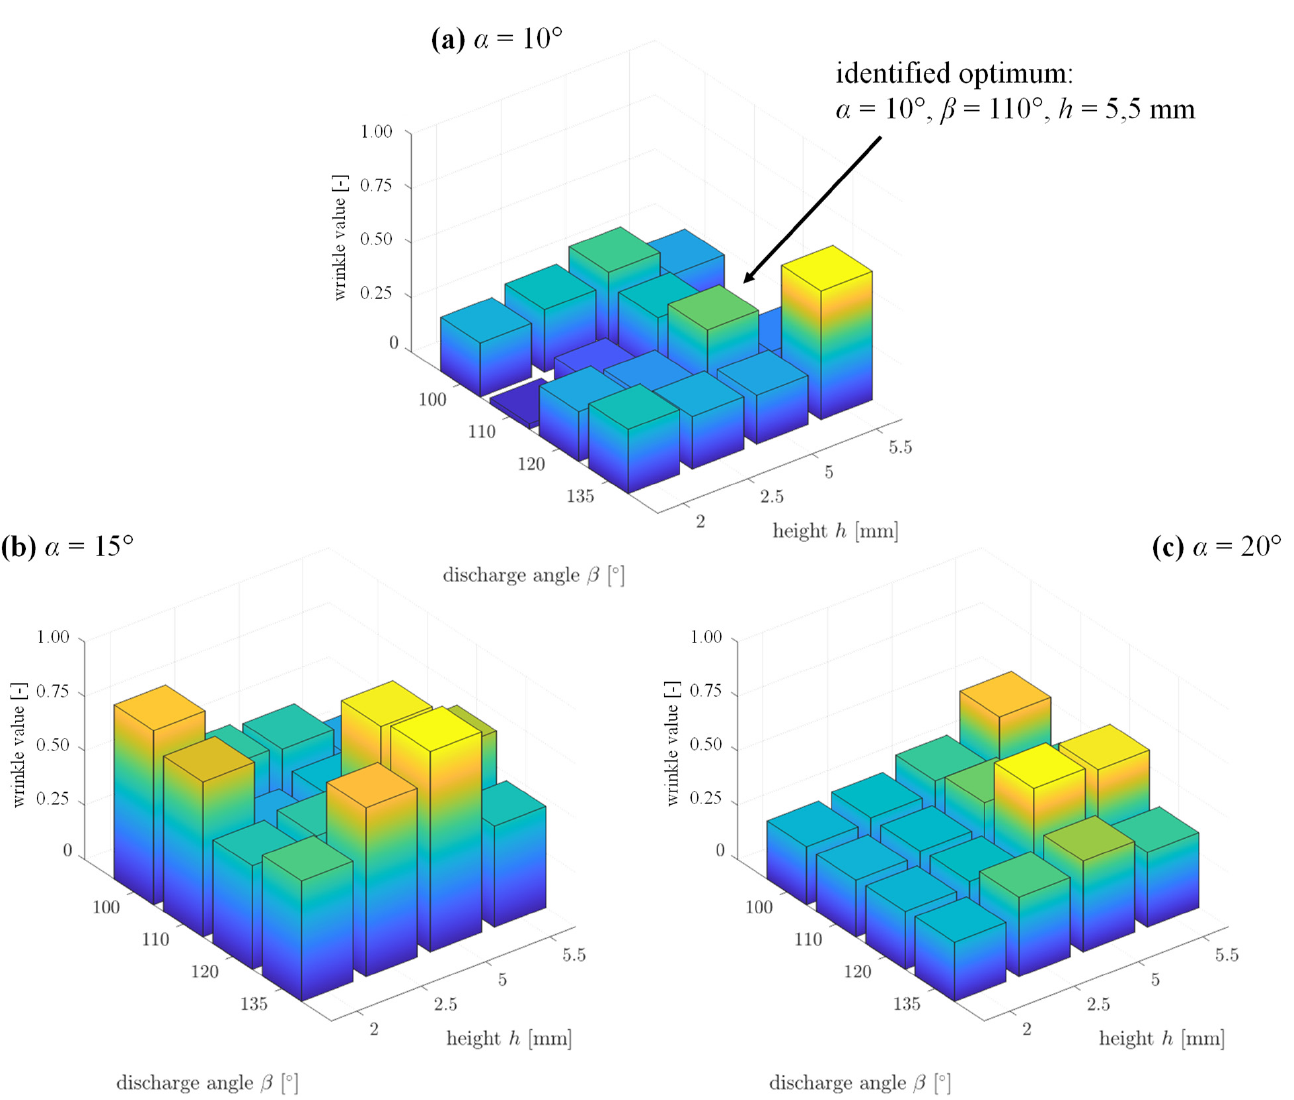
Figure 13. Simulation results of the wrinkle value of the full factorial parameter study: Angle α = 10° ( a ), angle α = 15° ( b ), and angle α = 20° ( c ).